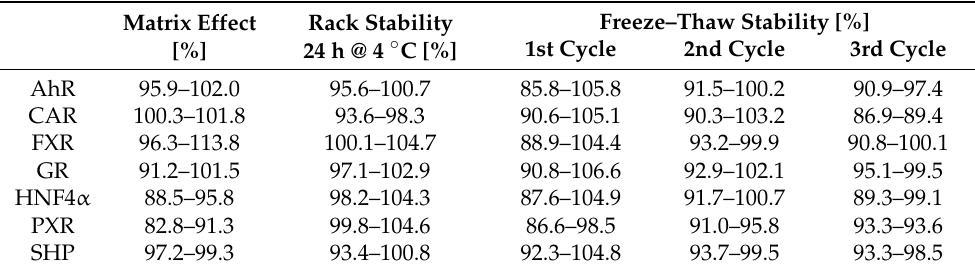
Table 3. Mean data for matrix effects and stability as assessed by analyzing, in each case, six quality control sample sets. AhR, aryl hydrocarbon receptor; CAR, constitutive androstane receptor; FXR, farnesoid X receptor; GR, glucocorticoid receptor; HNF4 α , hepatocyte nuclear factor 4 α ; PXR, pregnane X receptor; SHP, small heterodimer partner. Matrix